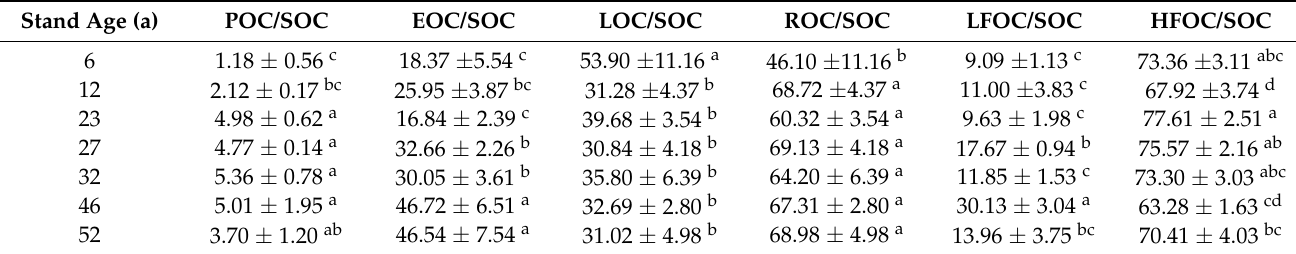
Table 2. Proportion (%) of carbon fractions to SOC of C. japonica plantation at different stand ages in the rainy area of western China.